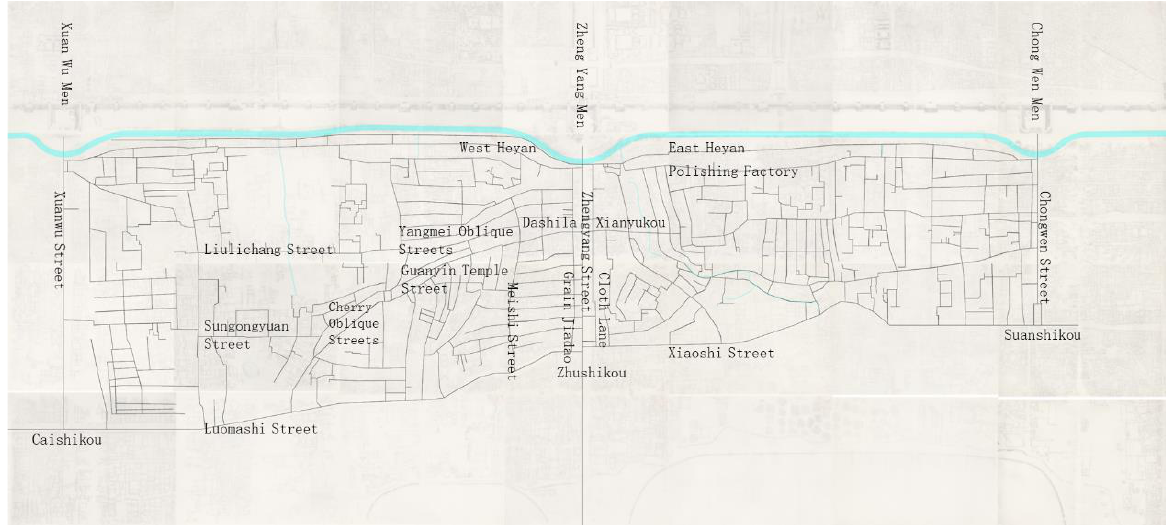
Figure 2. Street and alley map in Qianmen area during the Qianlong